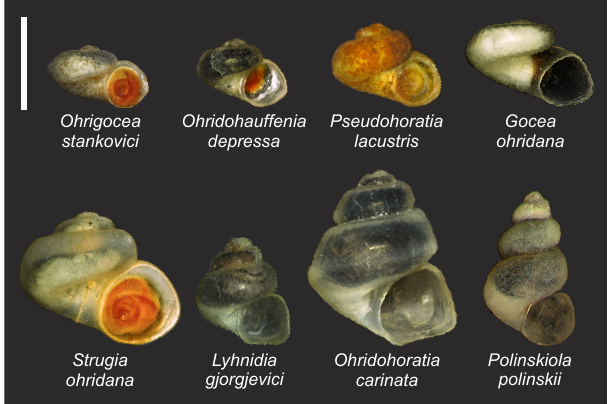
Figure 1. Selected representatives of genera belonging to the en- demic non-pyrgulinid Hydrobiidae from Lake Ohrid. Scale bar: 1mm.